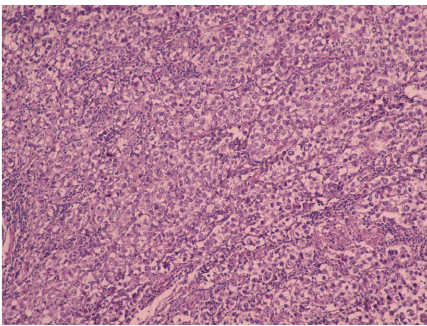
Figure 3: Uniform tumor cells arranged in nests, separated by delicate fibrous stroma rich in lymphocytes ( × 5; H&E